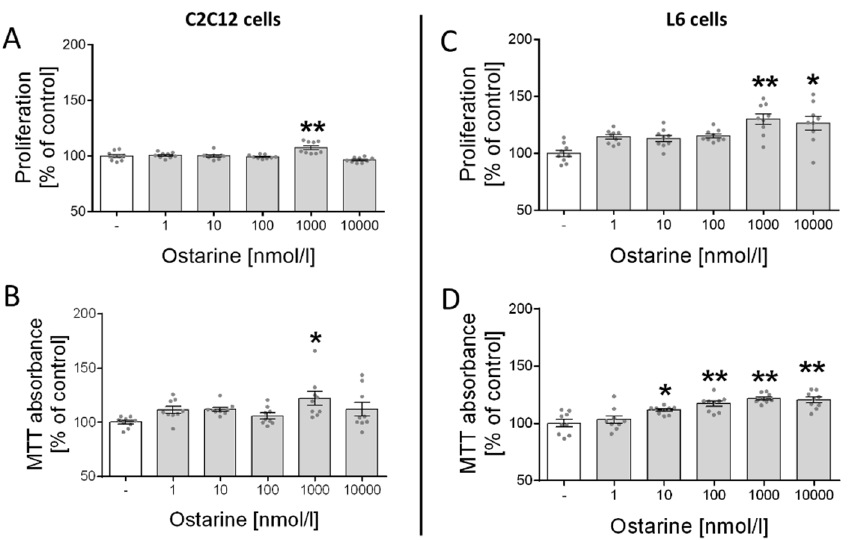
Figure 1. Effect of ostarine on ( A , C ) proliferation and ( B , D ) cell viability in C2C12 and L6 cells. Results are shown as percentage of control group (set to 100%), as mean ± standard error of mean (SEM) derived from n = 9 experiments ( n = 3 per group with 3 repetitions of each). Statistically significant differences are represented as * p < 0.05 and ** p < 0.01 versus corresponding control using one-way ANOVA followed by Dunnett’s post hoc test.